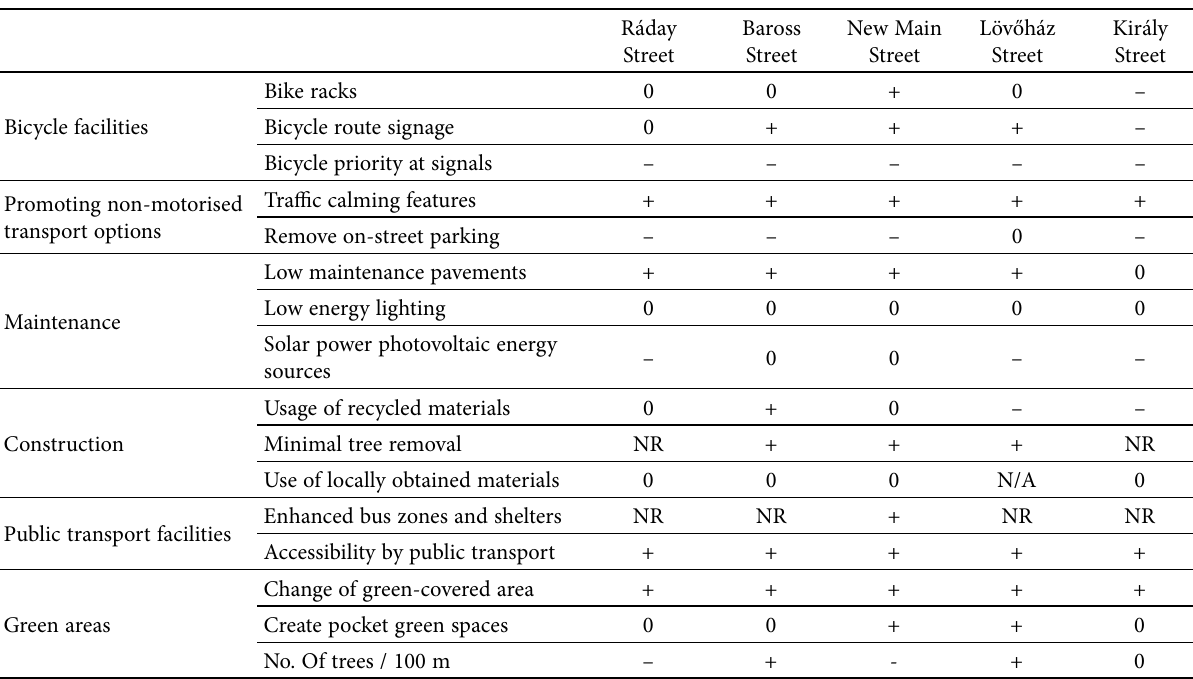
Table 3. Mitigation-oriented features of the renewed streets